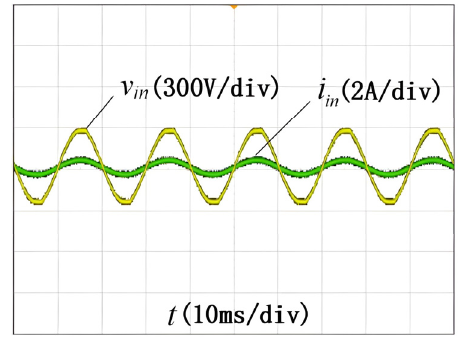
Figure 9. Waveforms of v in and i in .